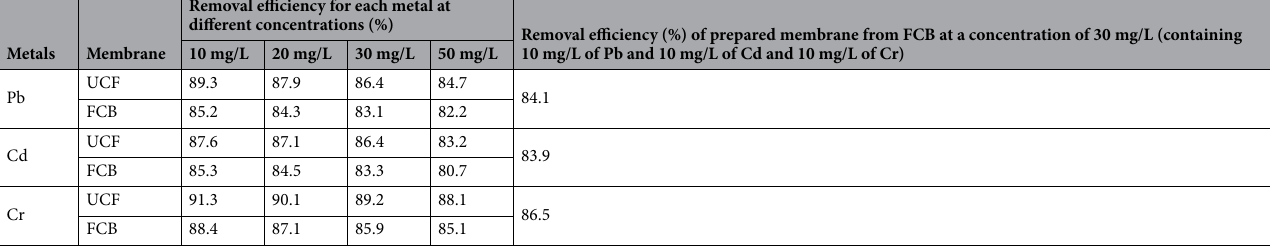
Table 2. Removal efficiency of membranes for heavy metals at different